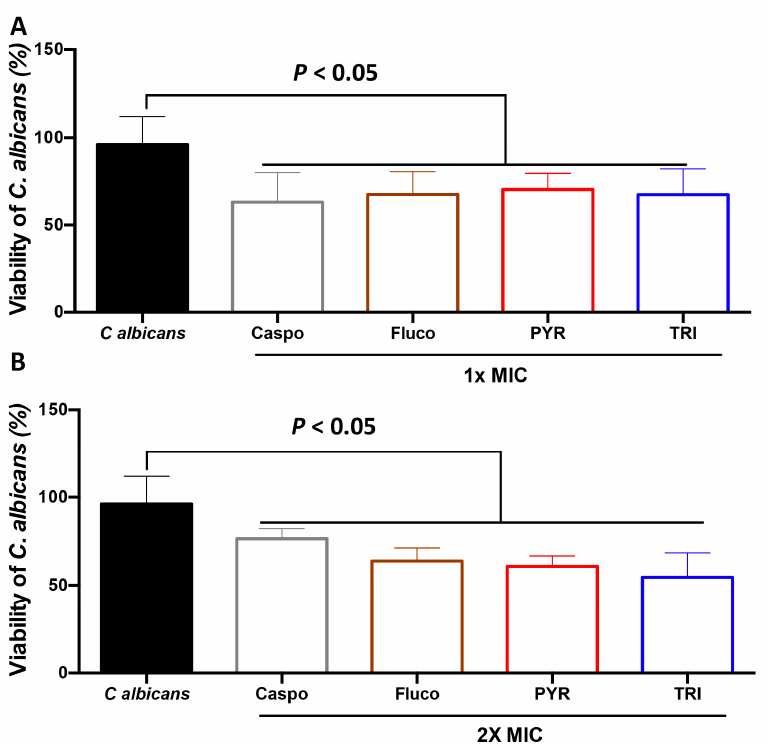
Figure 2. Viability of C. albicans by culture assay in the presence of caspofungin, fluconazole, PYR, or TRI. C. albicans SC5314 cells were challenged with caspofungin (Caspo), fluconazole (Fluco), PYR, or TRI at their ( A ) 1× MIC, or ( B ) 2× MIC. C. albicans (control) corresponds to C. albicans alone without any antifungal treatment. Error bars indicate standard deviations.